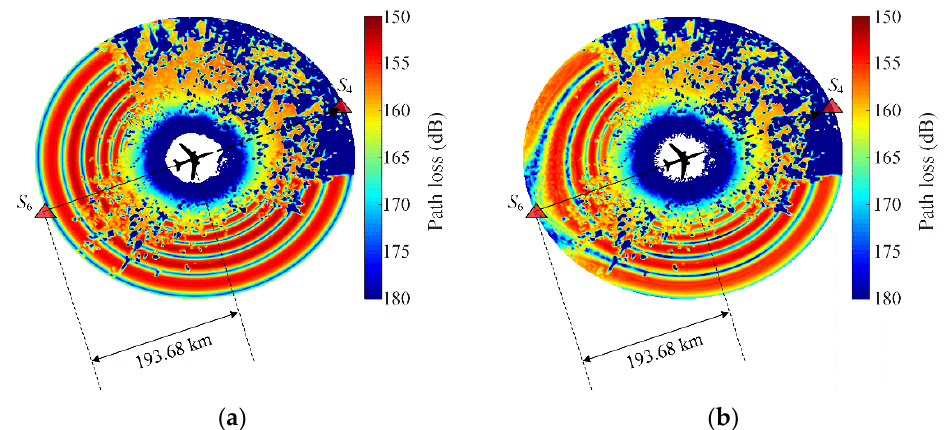
Figure 7. Illuminated electromagnetic field intensities on the terrain in relation to the atmospheric conditions: ( a ) the standard atmospheric conditions and ( b ) the observation-based atmospheric conditions on 15 February 2019.